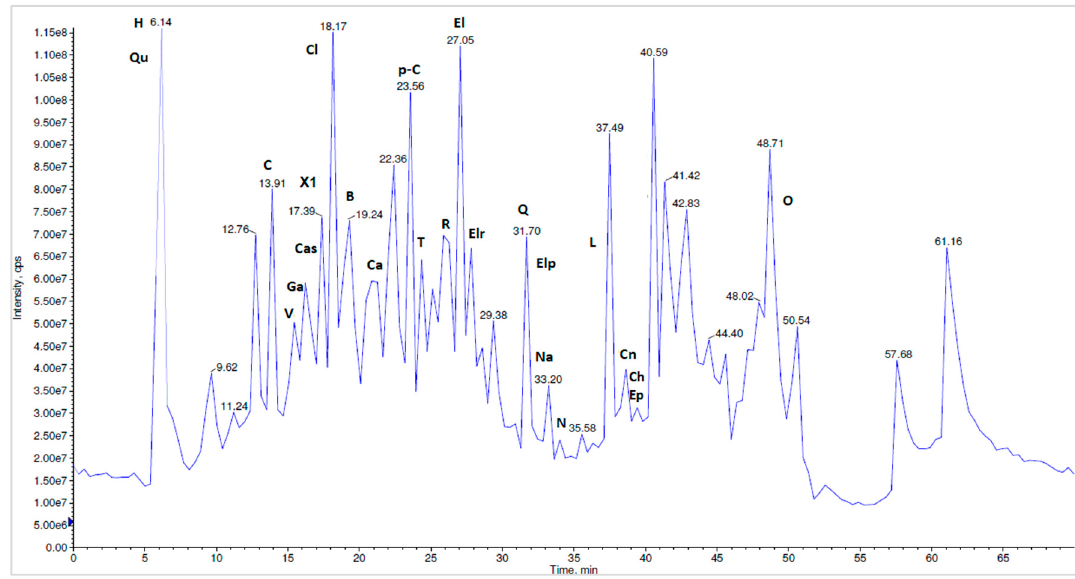
Figure 10. The LC-MS/MS chromatographic separation of the methanolic N. alba leaf extract